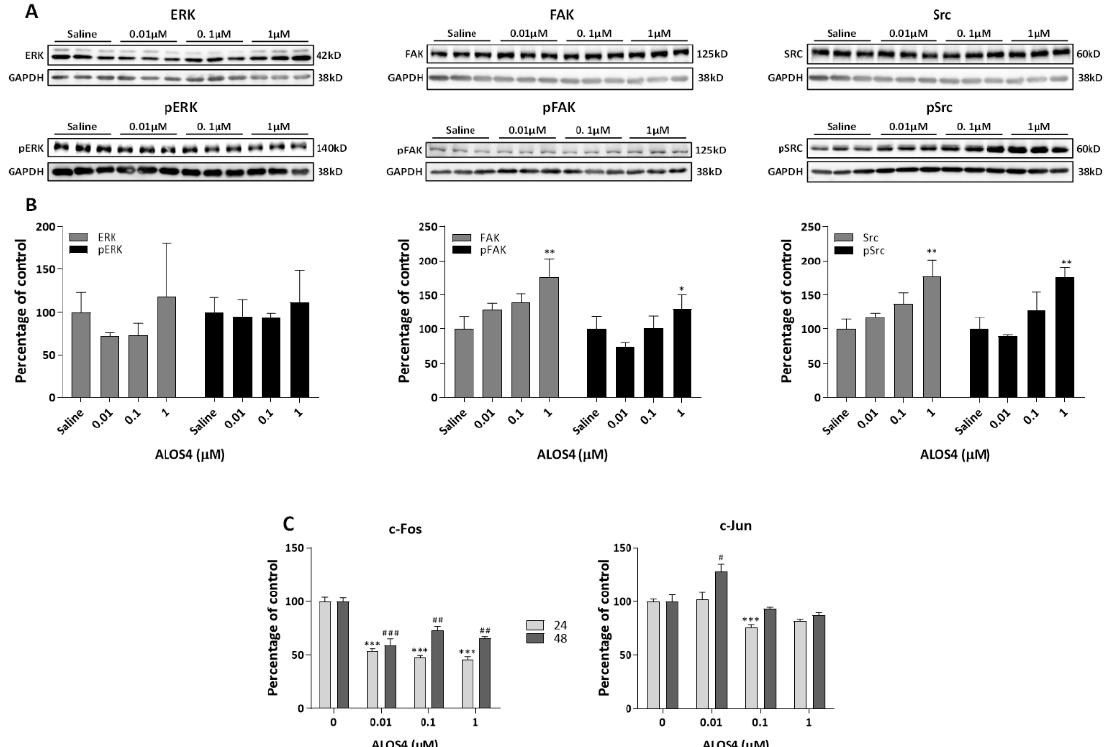
Figure 3. Effect of ALOS4 on α v β 3 integrin signaling. Representative gel bands ( A ) and Western blot densitometry results ( B ) performed for A375 cells treated for 48 h with ALOS4 at 0.01, 0.1, or 1.0 µ M and analyzed for ERK/pERK, FAK/pFAK, and Src/pSrc protein expression. Data are presented as percentage of control normalized to GAPDH, n = 3 for each treated group. ( C ) A375 cells treated for 24 ( n = 6) and 48 ( n = 3) h with ALOS4 at 0.01, 0.1, or 1.0 µ M were analyzed for c-Fos and c-Jun mRNA expression using qRT-PCR. Data presented as percentage of control. */# at p < 0.05, **/## at p < 0.01, and ***/### at p < 0.0001.